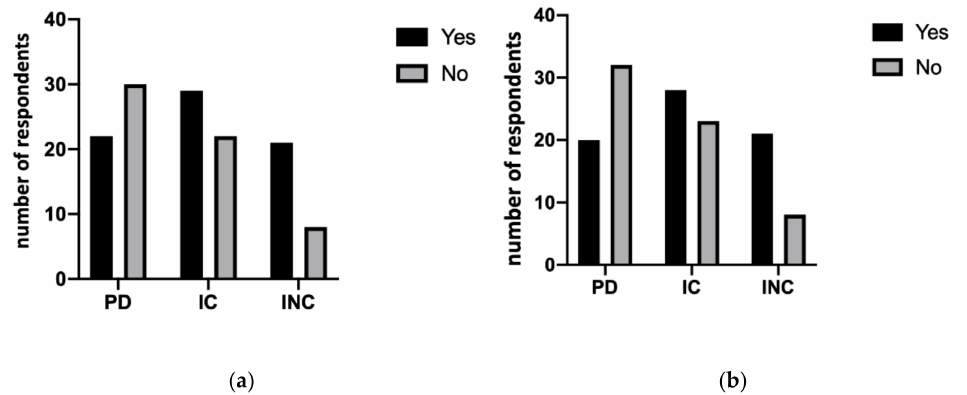
Figure 3. ( a ) The difficulty expressed by dentists to understand the needs of people with disabilities showed significant differences ( p < 0.05) between the three groups. ( b ) It also showed the necessity of dentist to stop any treatment (yes) or not (no) ( p <